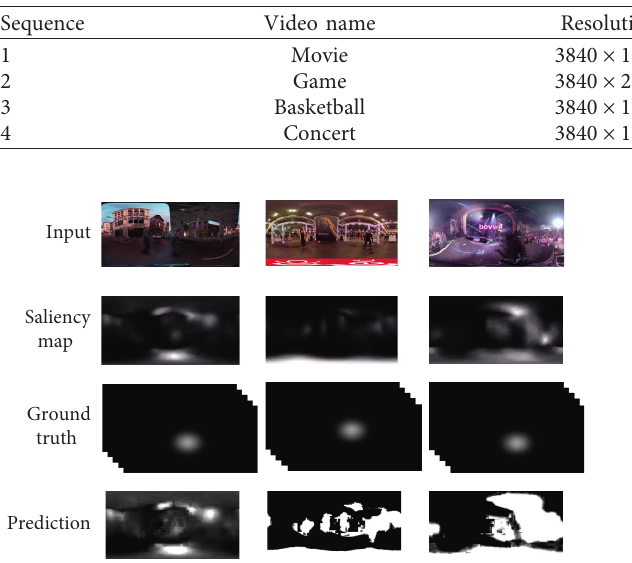
Figure 5: The saliency maps of only one frame are shown for each selected video. The prediction map is derived by combining the saliency map with the ground-truth user viewport.